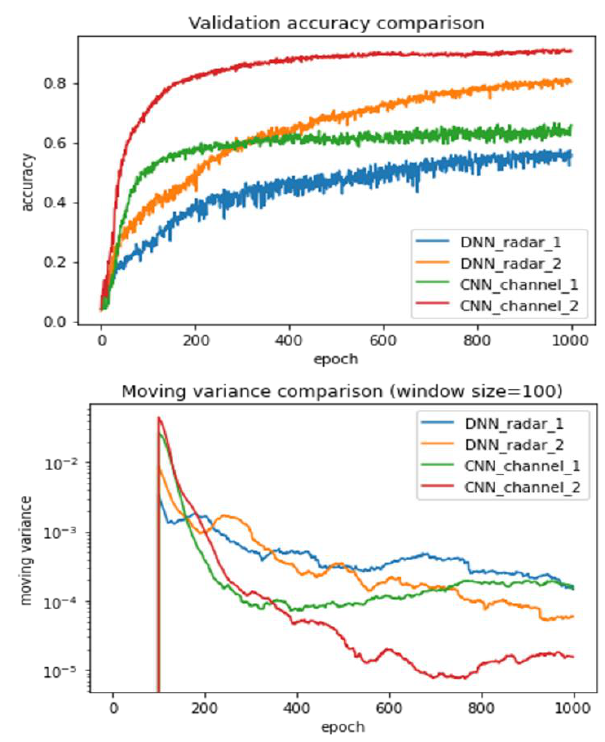
Figure 10. Validation accuracy comparison for the proposed models.